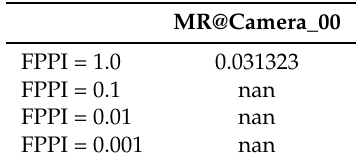
Table 6. Accuracy table @ Camera_00, YOLOv3.